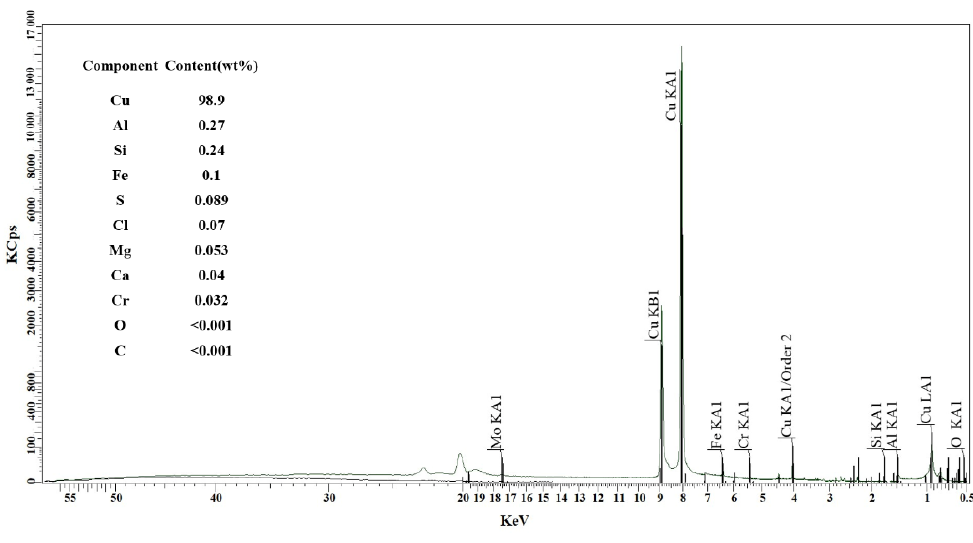
Figure 6. XRF spectral line diagram of the sintered sample.